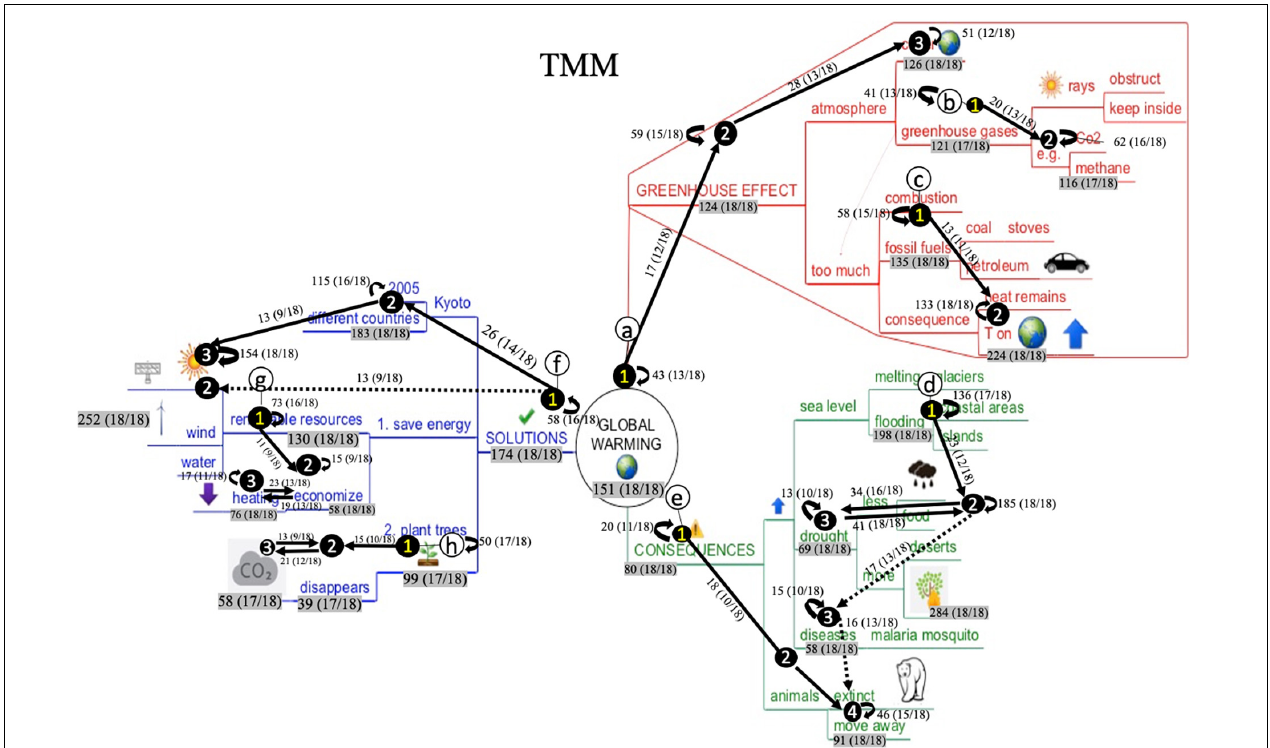
FIGURE 9 | Aggregated process map of the Text-Mind Map (TMM) condition students.